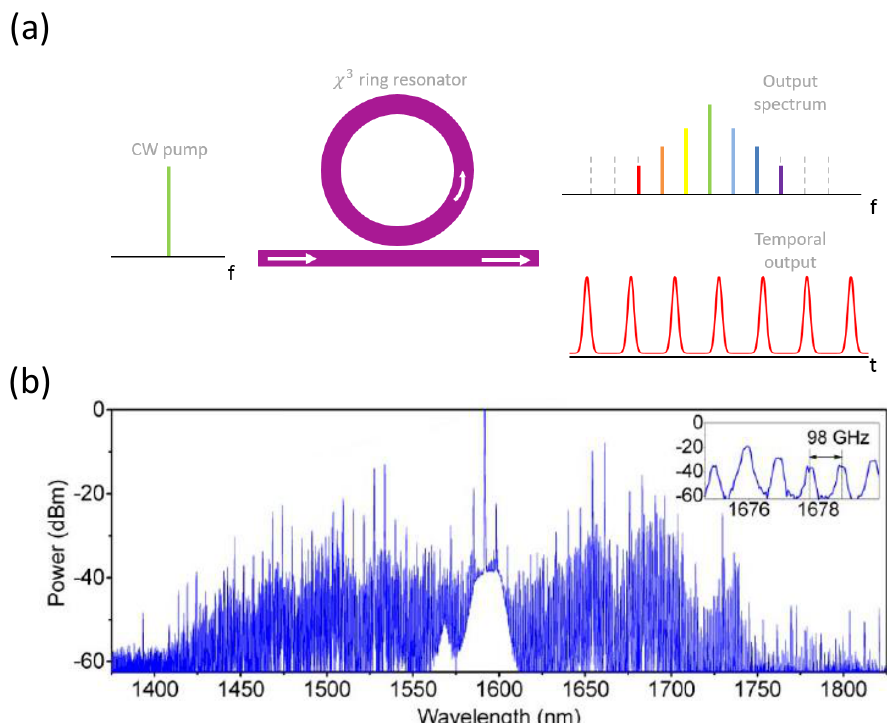
Figure 14. Kerr frequency microcomb generation in an AlGaAs-OI MRR. ( a ) Schematic illustration of the basic idea: an input spectrum, an MRR, and an output spectrum and temporal output. The grey dashed lines in the output spectrum show the MRR frequency modes. The temporal output shows successive pulses (solitons). ( b ) Kerr frequency comb spectrum generated in an AlGaAs-OI MRR driven by 72 mW of CW pump power at 1590 nm. The spectral distance between the lines is 98 GHz. Adapted with permission from [8] ©The Optical